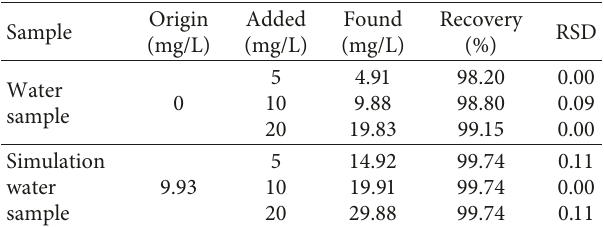
Table 1: The recovery test results of extraction by